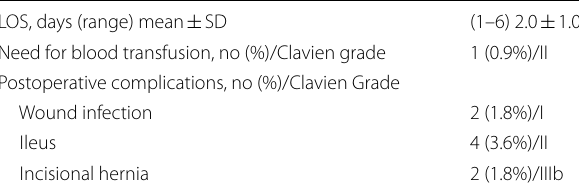
Table 3 Postoperative findings for the study